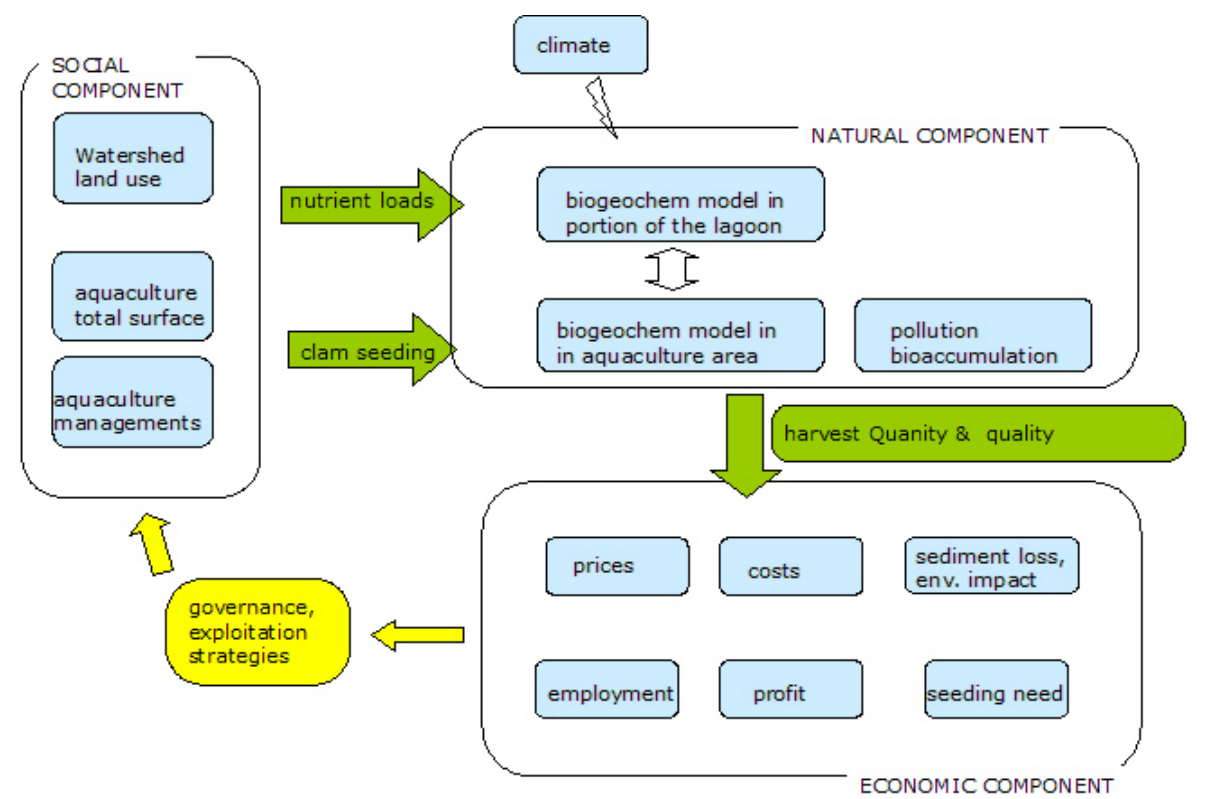
Fig. 3. Scheme of the integrated ecological-social-economical (ESE) model